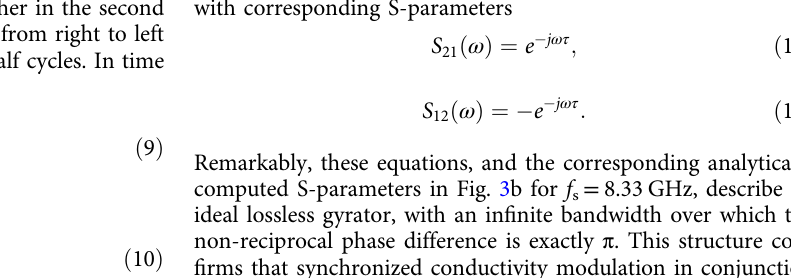
NATURE COMMUNICATIONS | 8: